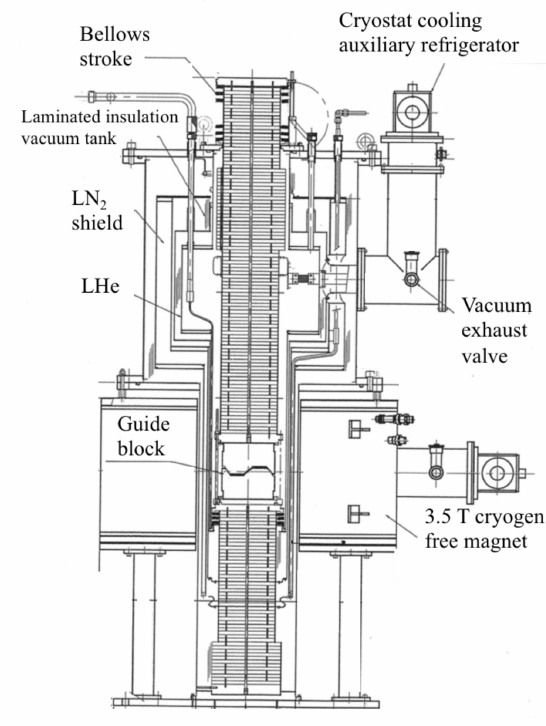
Figure 3: Cross-sectional view of the top-loading cryo-